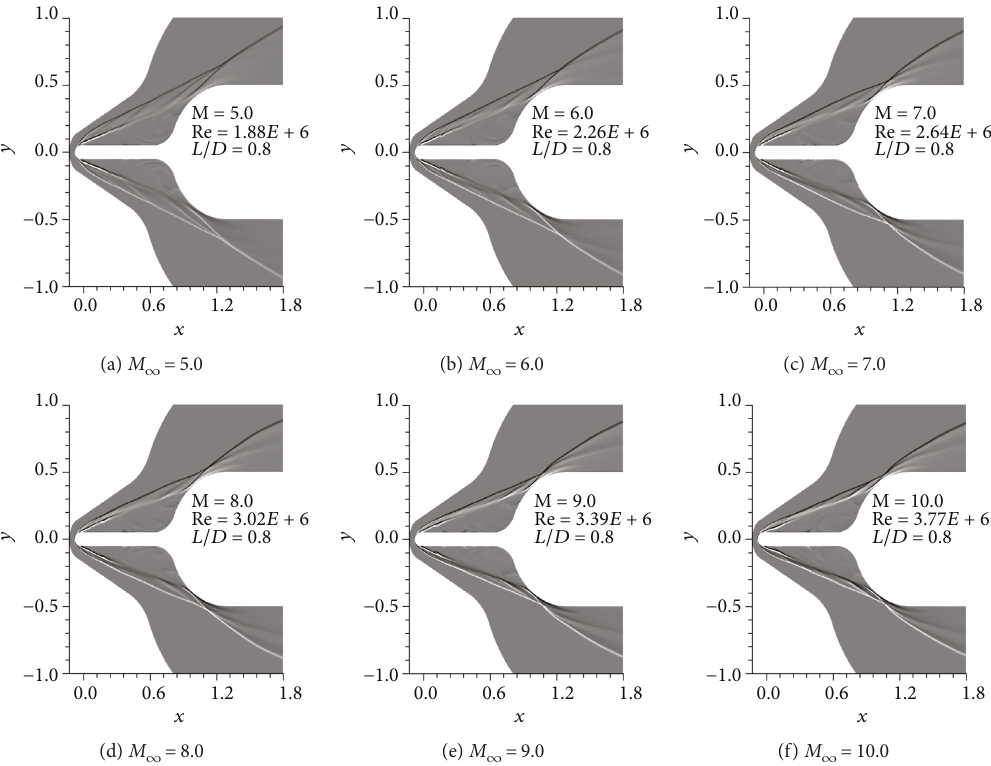
Figure 12: Flow fi eld density gradient in y direction of spiked blunt bodies with the sideward sonic jet. Spike length L/D =